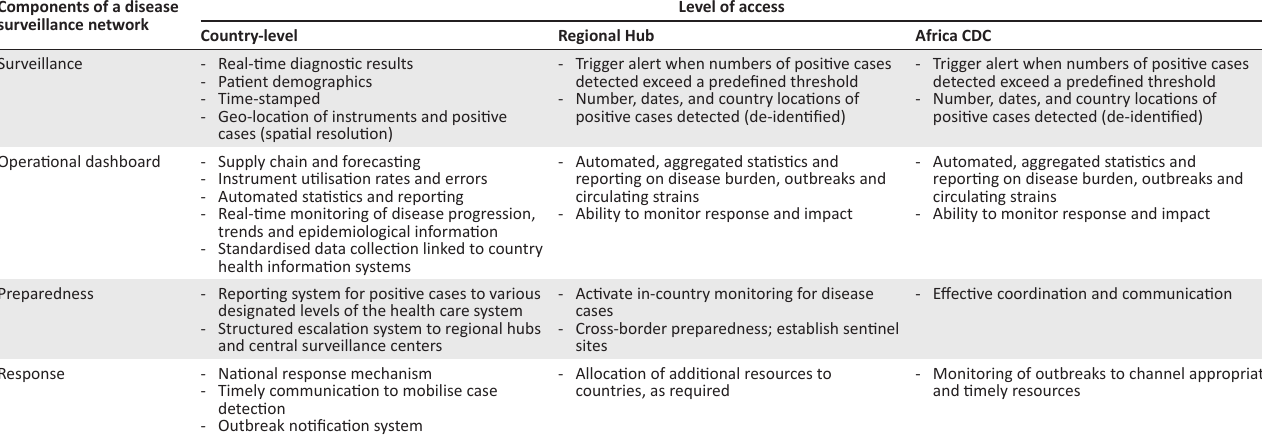
TABLE 1: Bottom-up approach to a continent-wide disease surveillance network showing how access can be restricted based on permissions. Components of a disease surveillance